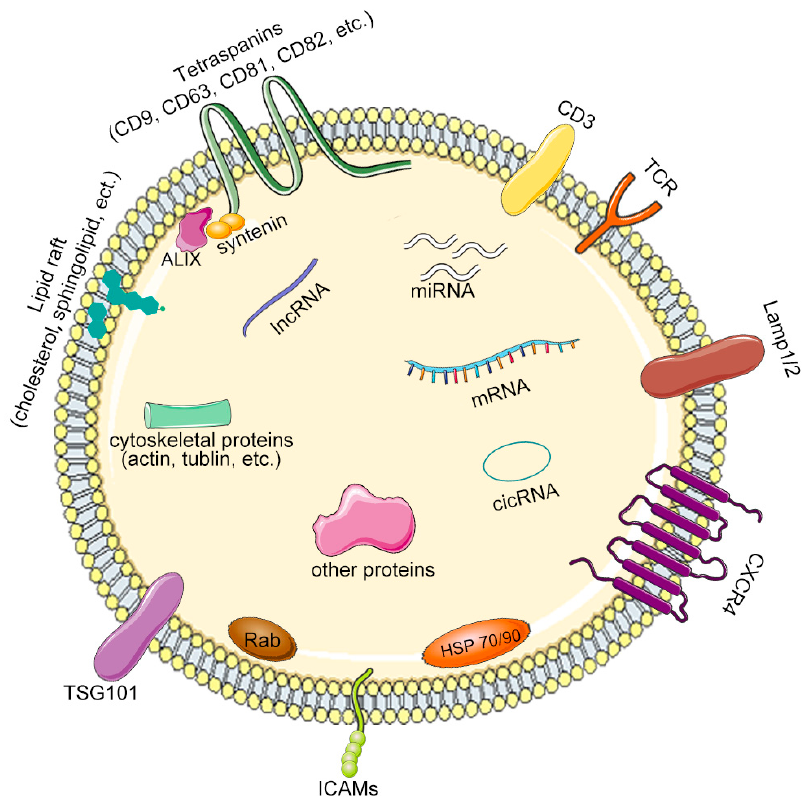
Figure 2. Rich contents and surface markers of exosomes. Exosomes are rich in cholesterol and sphingomyelin and have a lipid bilayer structure. Universally, exosomes contain tubulin, heat shock proteins, actin-binding proteins, ALIX, tetra membrane proteins, abundant nucleic acids, etc. CXCR4: CXC chemokine receptor 4; TCR: T cell receptor; HSP: heat shock proteins; ICAMs: inter- cellular cell adhesion molecules; TSG: tumor suppressor gene; lncRNA: Long non-coding RNA; miRNA: micro-RNA; cicRNA: circular RNA.